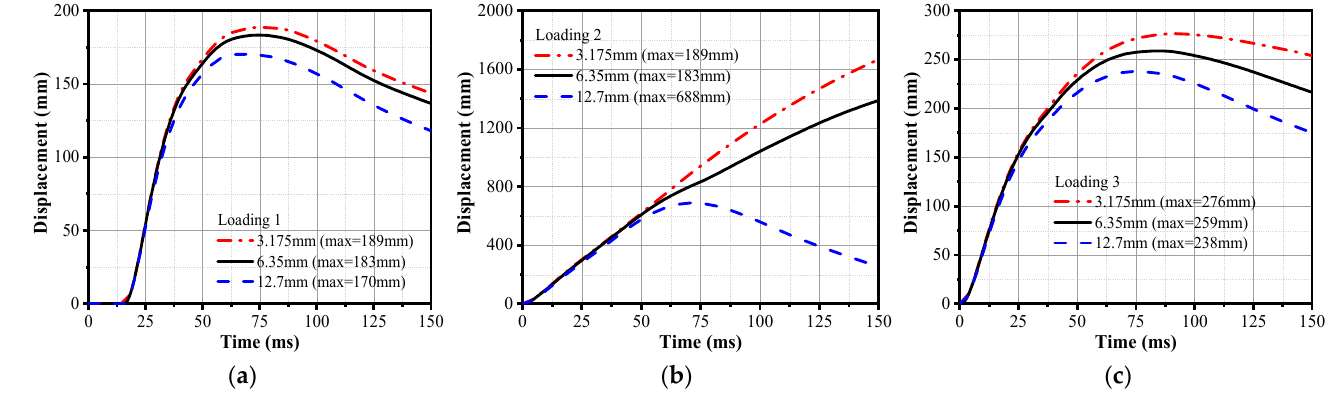
Figure 14. Influence of SPUA layer thickness to wall center displacement-time histories under different loadings: ( a ) Load 1; ( b ) Load 2; ( c ) Load 3.